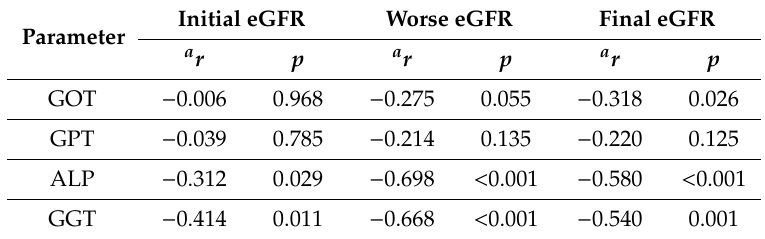
Table 2. Correlation analysis between renal function and liver function profile.